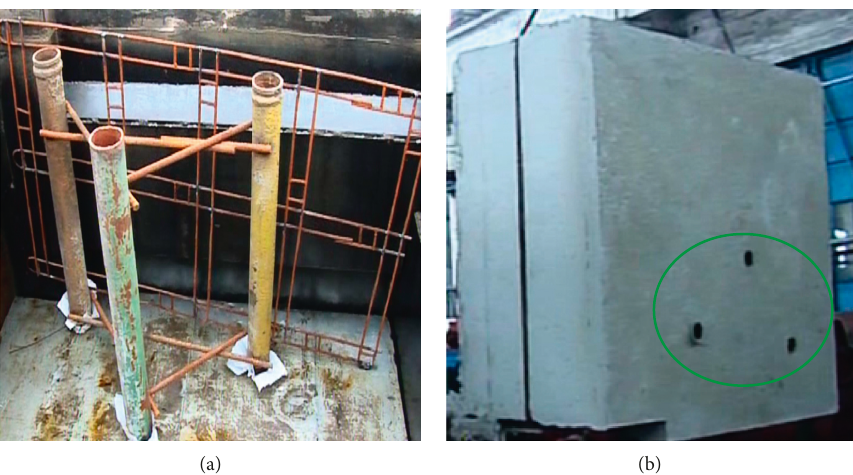
Figure 9: Pictures of strengthen structure for block bearing performance.